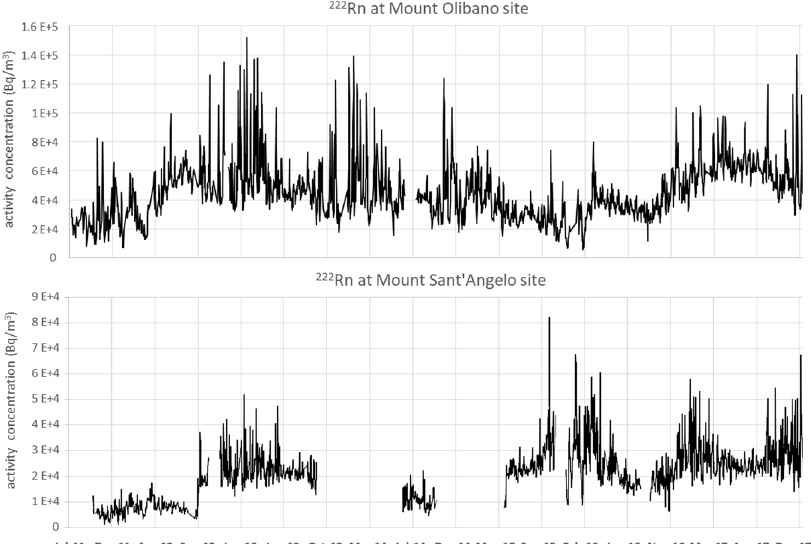
Figure 2. Radon time series recorded at OLB and MSA sites. The two series of radon activity concentrations (Bq/m 3 ), corrected for meteorological influences with the MLR method, recorded in the two monitoring sites at Monte Olibano ( a ) and Monte Sant’Angelo ( b ) within the caldera of Campi Flegrei, are shown. Some lack of data is due to the failure of the data logging